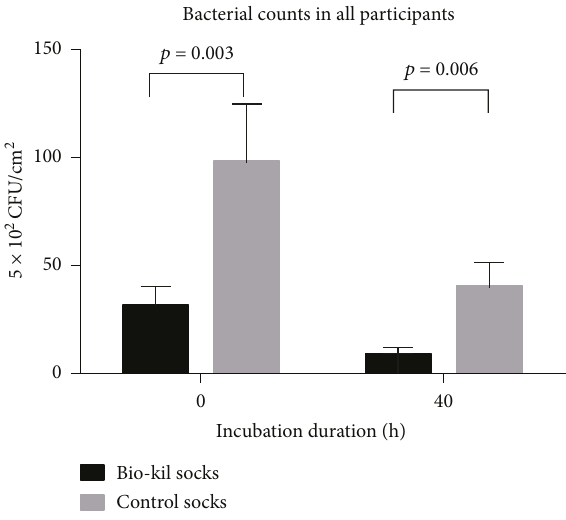
Figure 3: Bacterial counts in Bio-Kil-treated socks and control socks in healthy